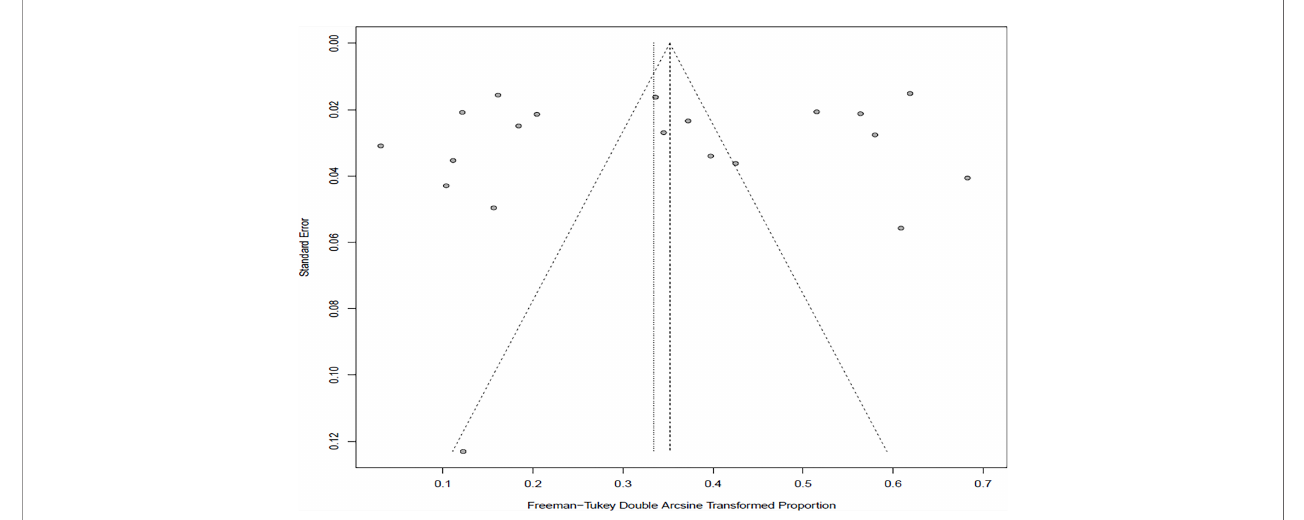
FIGURE 2 | Funnel plot with pseudo 95% con fi dence interval for publication bias